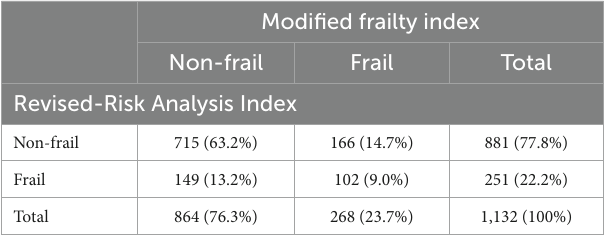
TABLE 4 Association of frailty with life-threatening morbidity and mortality (logistic regression analyses).